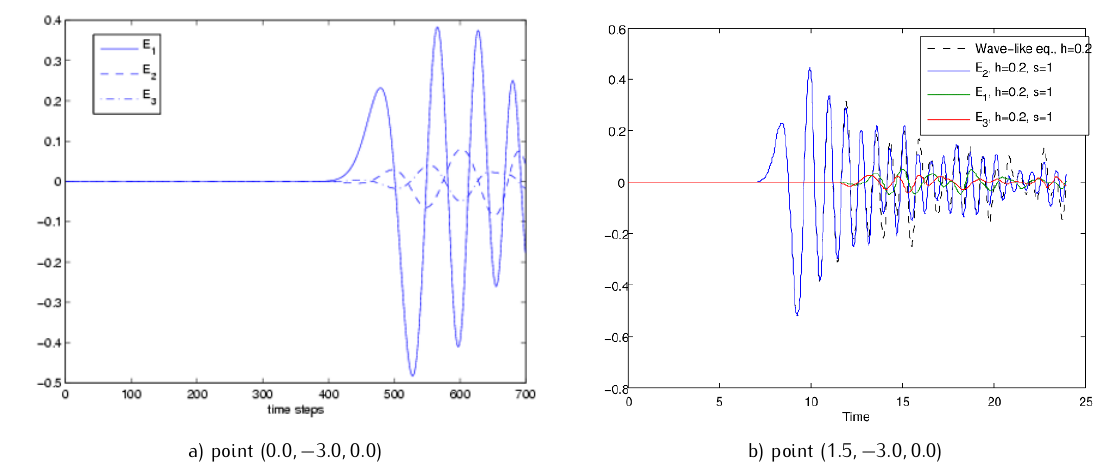
Figure 19. Test 4. Behavior of the computed electric field E time T = (0 , 12) (in this figure components of electric field are defined as E the horizontal axis denotes the number of time steps in